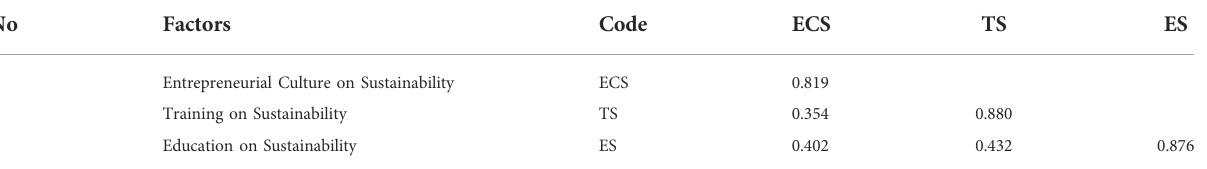
TABLE 3 Discriminant